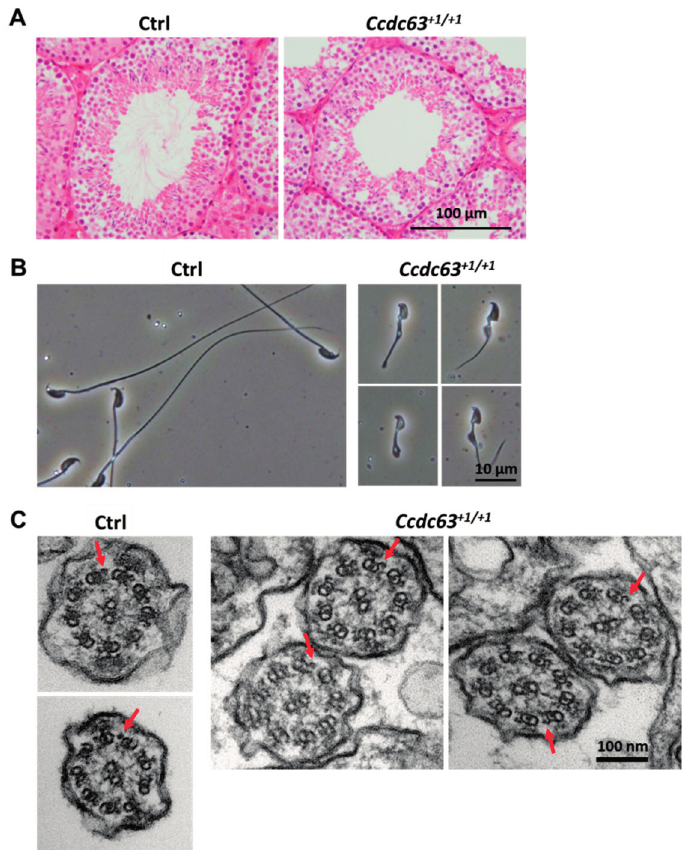
Figure 5. Histological and morphological analysis of Ccdc63 +1/+1 mice testis and spermatozoa; ( A ) Testis section of control (Ctrl) and Ccdc63 +1/+1 mice stained with Hematoxylin/Eosin ( B ) Sperm morphology of control and Ccdc63 +1/+1 mice; ( C ) Electron micrograph of a cross section of the end piece of sperm flagella of control and the flagella of Ccdc63 +1/+1 mice. Red arrowheads indicate